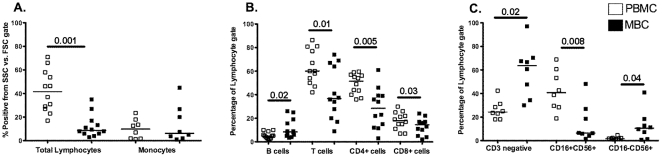
Cell composition of menstrual blood cells (MBCs).The percentage of various cell types present in menstrual blood versus PBMC were resolved by staining with cell type-specific surface markers. A. The total lymphocytes, were determined by the percentage of cells within a lymphocyte gate (small cells from FSC vs SSC plots) and monocytes (N = 8), are CD14+ cell from a leuokocyte gate (all cells within the larger FSC vs SSC plot), refer to Figure 1. B. Lymphocyte subsets present in menstrual versus peripheral blood. From the live cell gate, B cells were gated on CD19, T cells were gated on CD3 and T cell subsets were further divided into CD4+CD3+ and CD8+CD3+ T cells. C. Natural killer cell subsets (N = 8) gated from CD3- cells. CD16+CD56+ (cytotoxic NK cells) and CD16-CD56+ (immunoregulatory NK cells). The median is shown for data from 12 healthy women, except for monocytes and NK cells, where 8 samples were analyzed. Statistically significant differences (p<0.05) were obtained using Wilcoxon Signed Rank test.